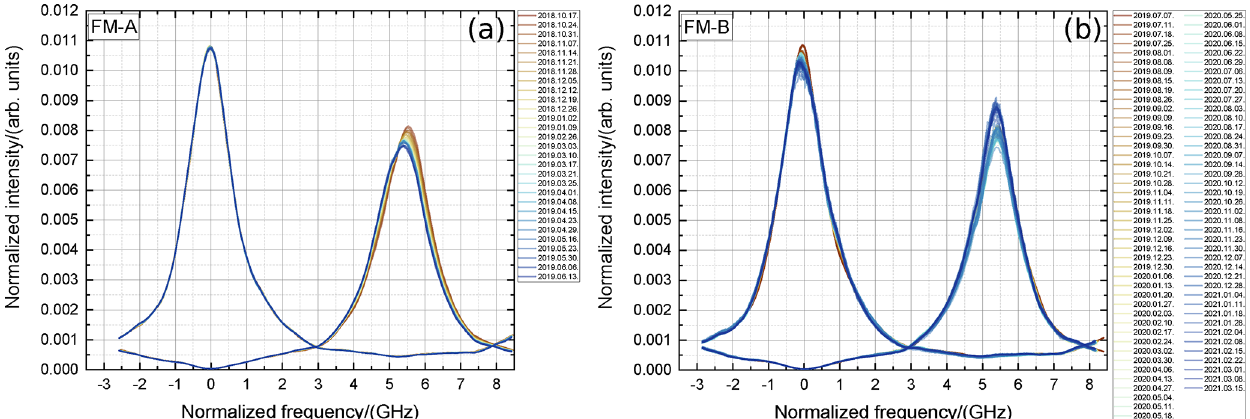
Figure 6. Normalized FPI transmission curves acquired during ISR measurements performed from 10 October 2018 to 15 March 2021 (see also Table 2) for the FM-A period (October 2018 to June 2019, a ) and FM-B period (July 2019 to March 2021, b